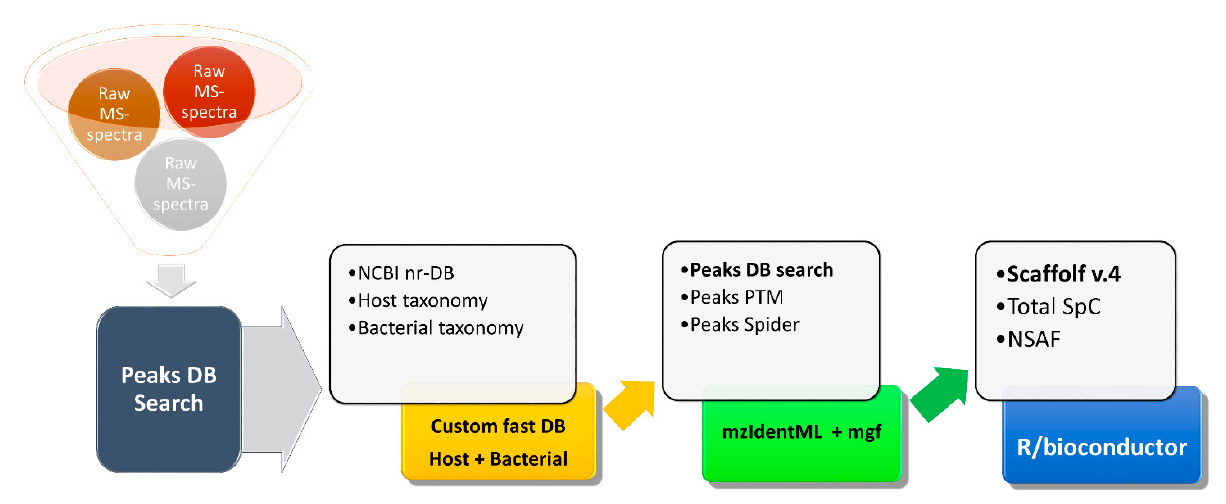
Figure 1. Experimental and analytical workflow. The metaproteomics data-analysis shows the software tools used to arrive at the identified proteins list.